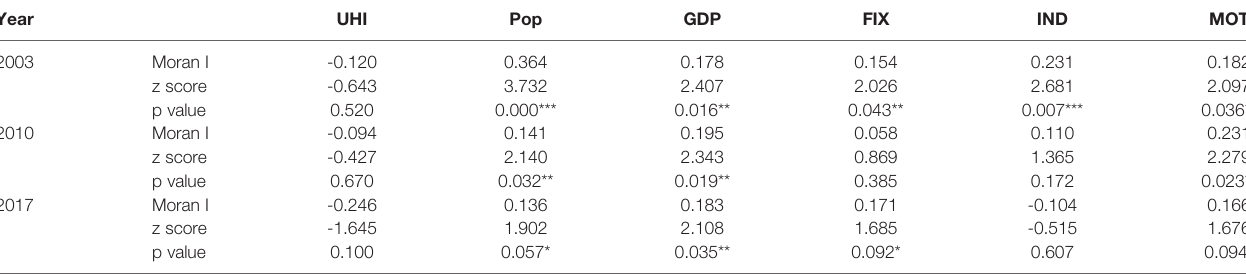
TABLE 2 | Global Moran ’ s I of UHI intensity and in fl uencing factors in the YRD. Year UHI